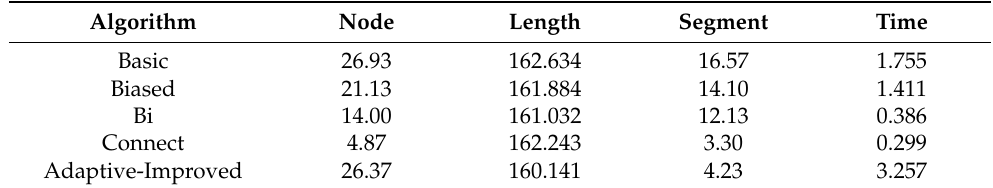
Table 4. Comparison of several RRT algorithms in the curved road environment: mean values in 30 runs.